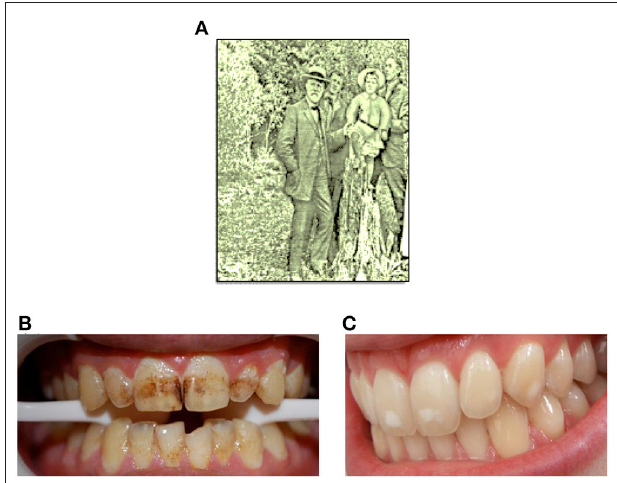
FIGURE 1 | (A) Dr. Black in Colorado Springs, 1909. (B,C) Typical photographic representations of “Colarado brown stain” and mild mottled enamel,